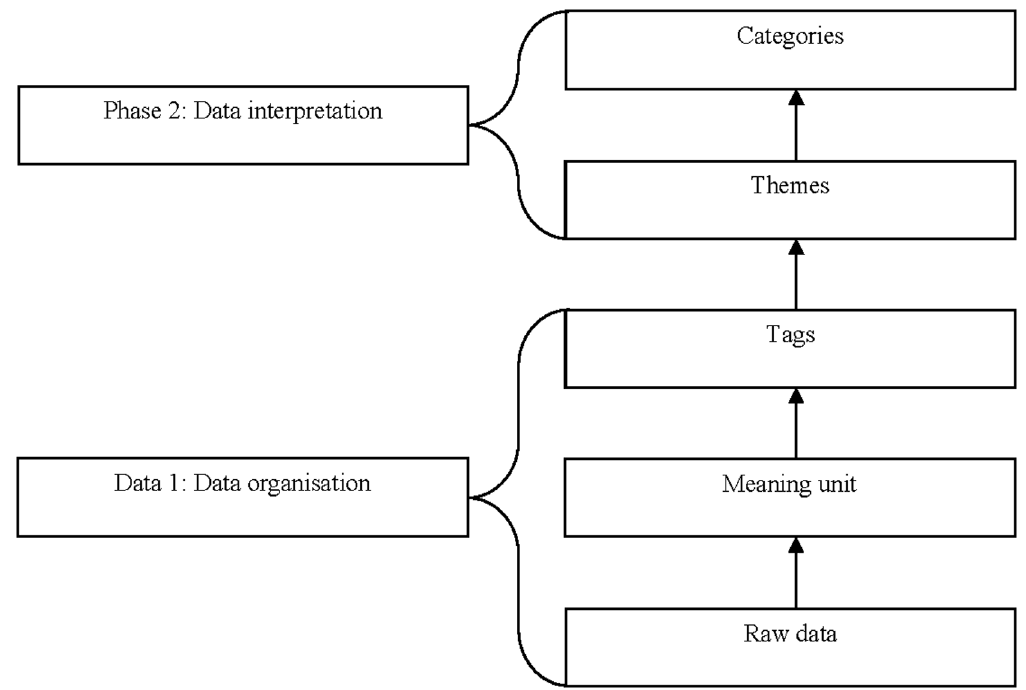
Figure 1. Data analysis process. doi:10.1371/journal.pone.0105960.g001 injury or health problems, and retirement from organised sports Table 3. Perceived role as coaches: summary of categories, themes, sub-themes, and example quotes.